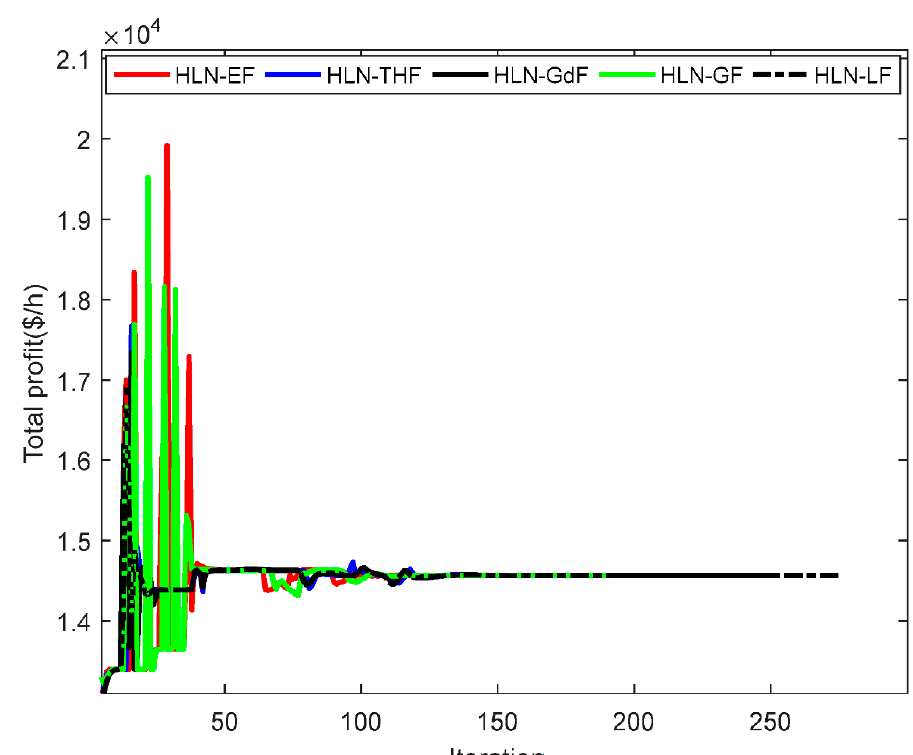
Figure 10. Total profit for the second system with the first model of payment.